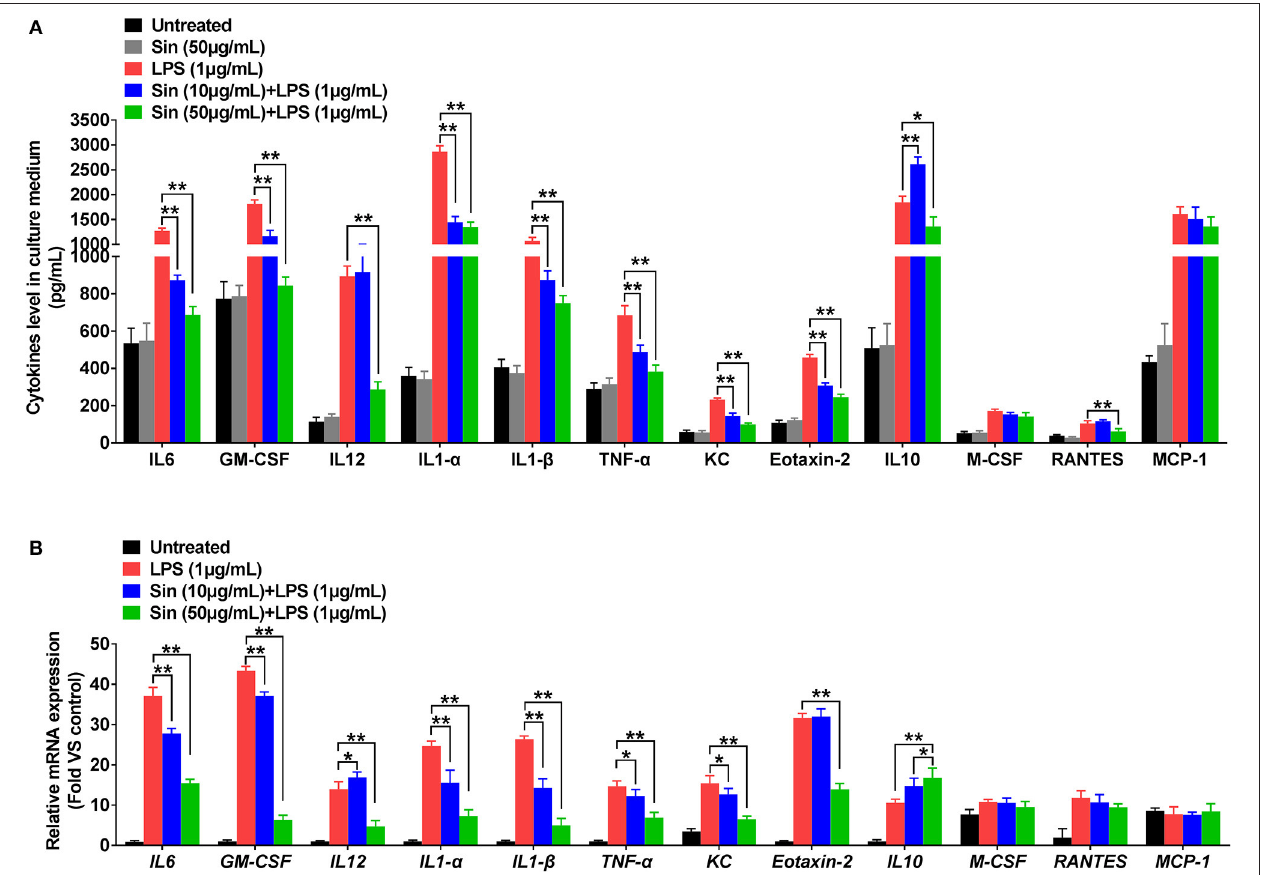
FIGURE 3 | RAW 264.7 cells were incubated with serum-free medium for 12h in 6-well plates, pre-treated with SIN (10 or 50 µ g/mL) for 2h, and finally co-stimulated with LPS (1 µ g/mL) for another 24h. (A) IL-6, GM-CSF, IL-12 p40, IL-1 α , TNF- α , IL-1 β , KC, Eotaxin-2, IL-10, M-CSF, RANTES, and MCP-1 release from conditioned medium was measured by ELISA, respectively. The values represent the means ± SD of triplicate experiments (* P < 0.05, ** P < 0.01). (B) Relative mRNA levels of the 12 selected cytokines by arrays were determined using RT-PCR. The results of RT-PCR were normalized to β -actin and expressed as fold change to the control. The values represent the means ± SD of triplicate experiments. * P < 0.05 vs. LPS treated